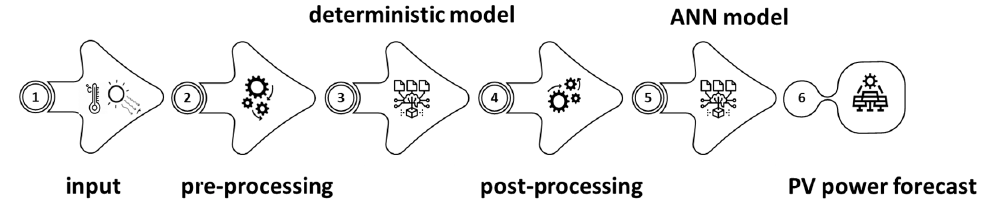
Figure 5. Diagram of the method used to predict the solar generation in each market zone.